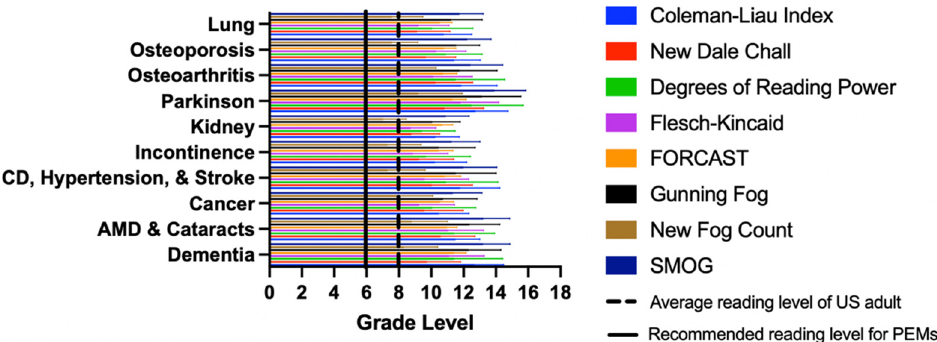
Figure 1. Mean grade level of online patient education materials found for each disease cluster (Lung disease, Osteoporosis, Osteoarthritis, Parkinson’s, Kidney disease, Incontinence, Cardiovascular disease [CD], Hypertension, and Stroke, Cancer, Age related macular degeneration [AMD] and Cataracts, and Dementia) using eight numerical scales, including the Coleman–Liau Index, New Dale–Chall, Degrees of Reading Power and Grade Equivalent test, Flesch–Kincaid Grade